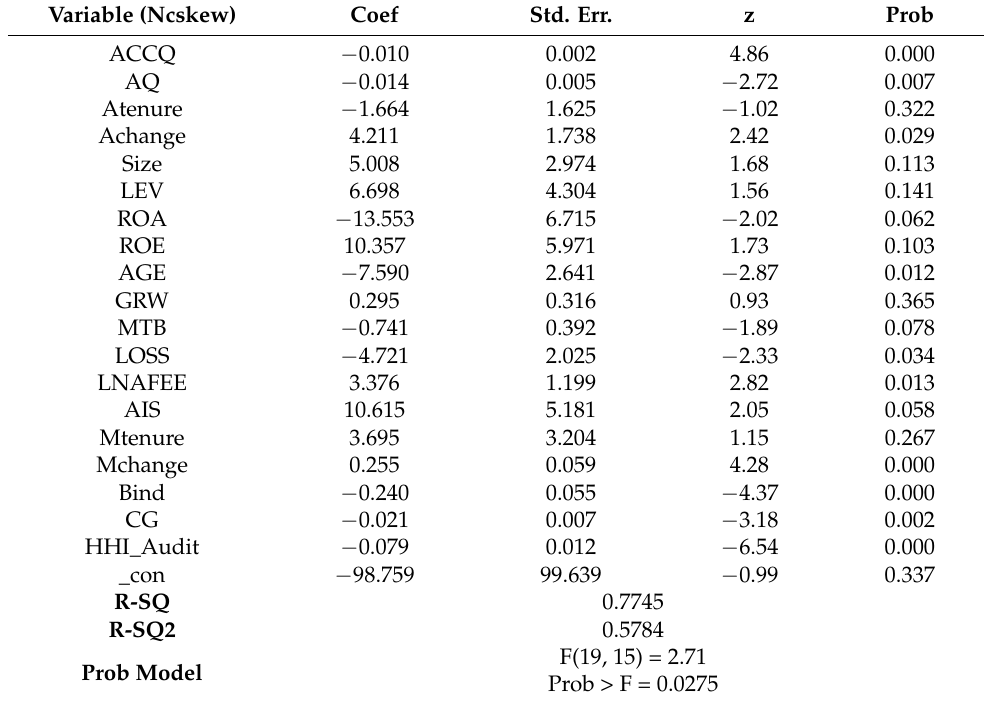
Table 9. The model specification for